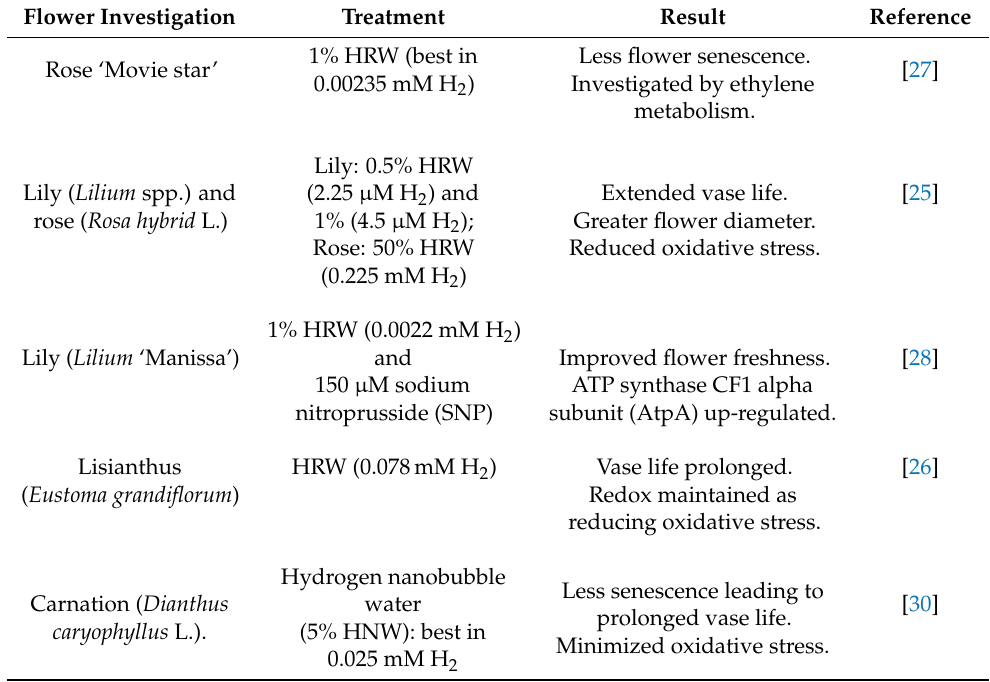
Table 2. Collection of H 2 treatments (Hydrogen-rich water—HRW, Hydrogen nanobubble water— HNW) for cut flowers in postharvest. H 2 concentrations are converted from the information given in the reference papers